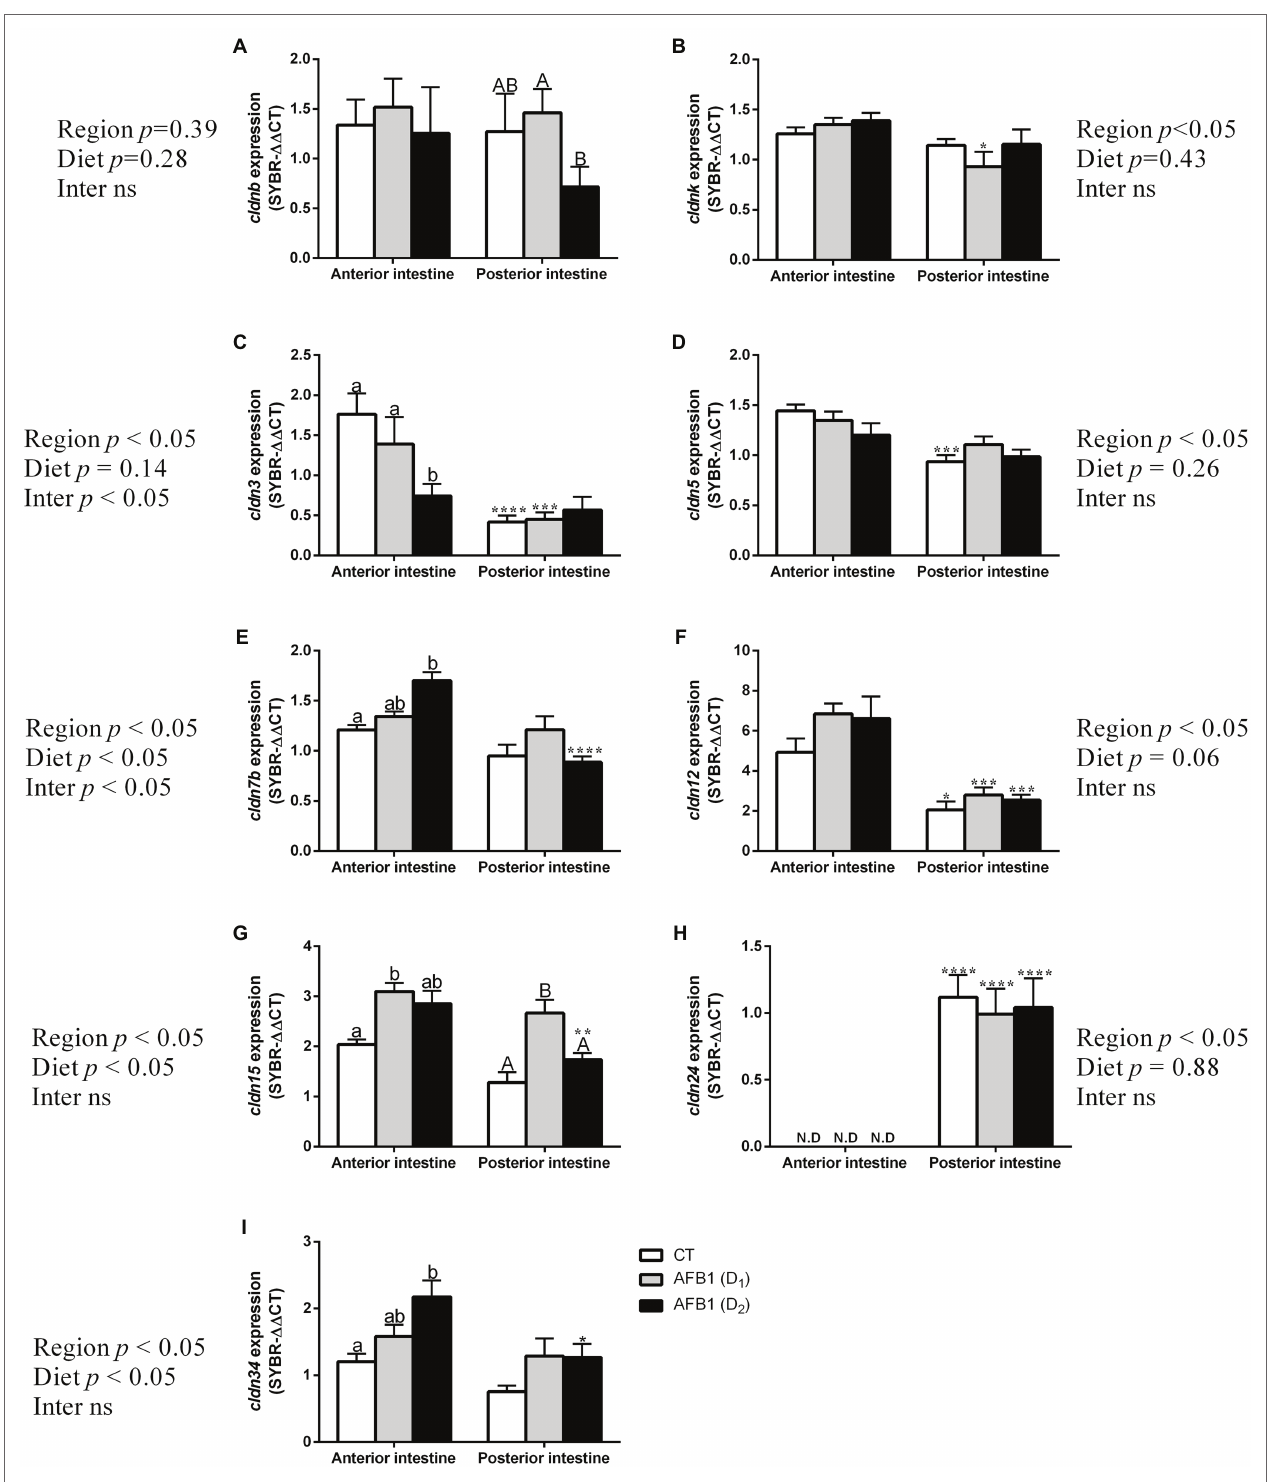
FIGURE 4 | Gene expression of cldnb (A) , cldnk (B) , cldn3 (C) , cldn5 (D) , cldn7b (E) , cldn12 (F) , cldn15 (G) , cldn24 (H) , and cldn34 (I) in anterior (AI) and posterior intestine (PI) of S. aurata juveniles fed with different experimental diets (CT, control; D 1 , 1 mg- and D 2 , 2 mg-AFB1 kg − 1 fish feed) for 85 days. Data are presented as mean ± SEM (n = 7–10). Different letters indicate significant differences among groups within the same intestinal region (lowercase letters: AI; capital letters: PI). Asterisks (*) indicate the significance level between different intestinal regions within the same experimental diet; Abbreviations, “ND”: not detected; “Inter ns”: interaction not significant ( p < 0.05, two-way ANOVA followed by Tukey’s post hoc